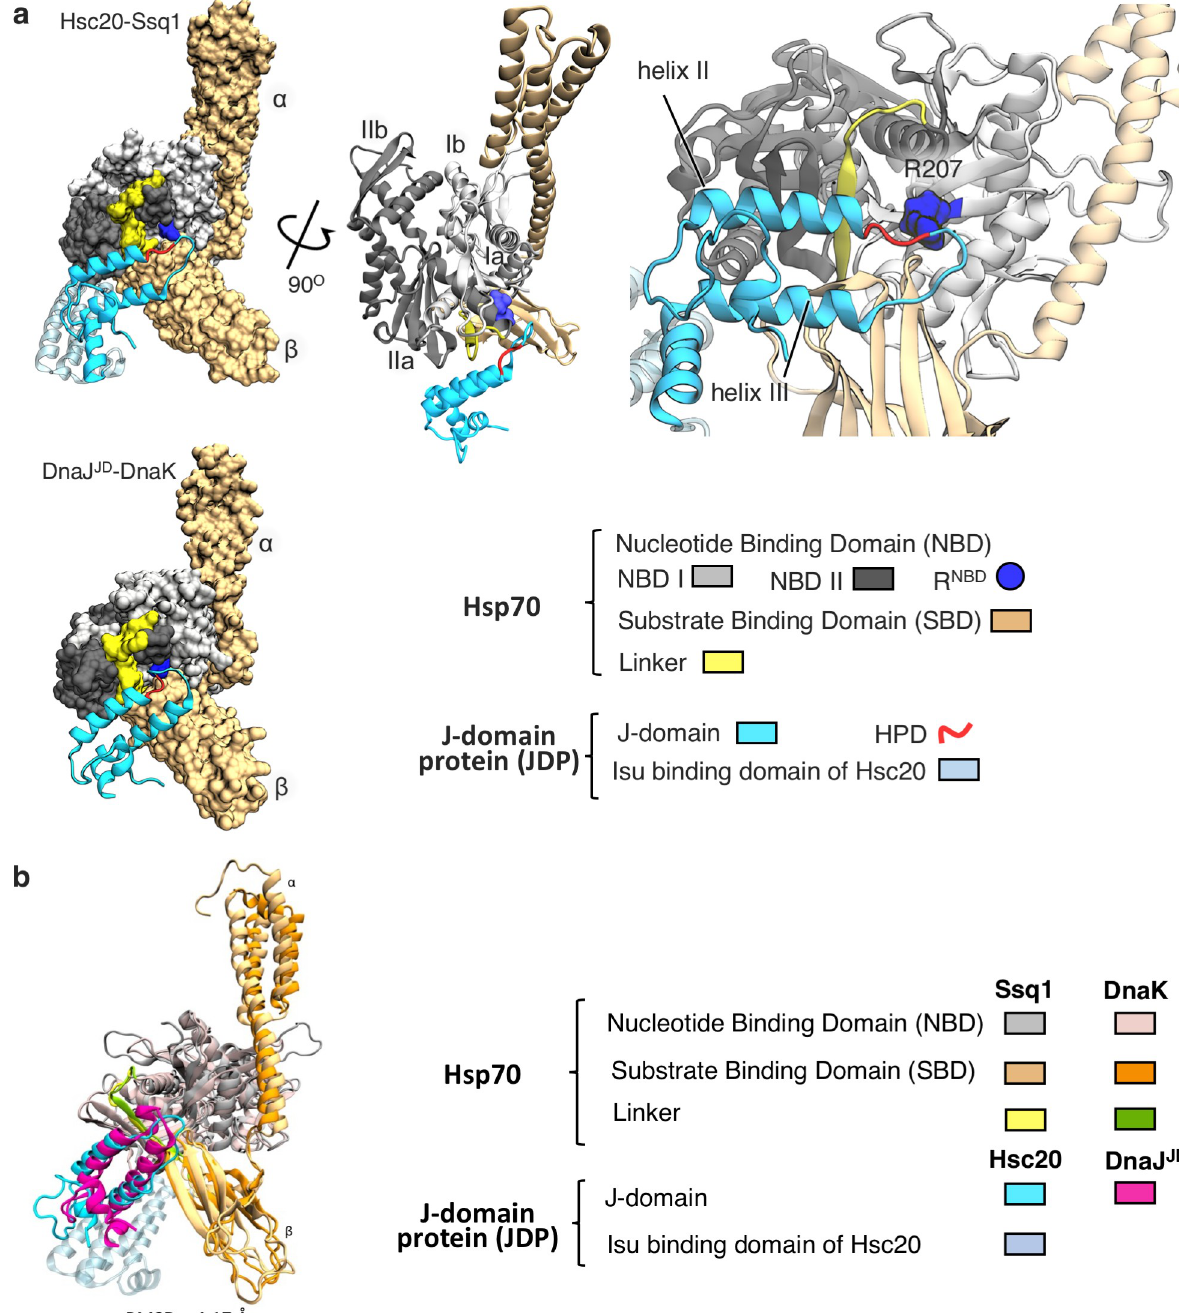
Fig 1. Binding mode of J-domain-Hsp70 complexes. (A) ( top left ) The dominant state of the Hsc20-Ssq1 complex obtained by protein-protein docking followed by MD refinement. Structure of S . cerevisiae Hsc20 (PDB ID 3UO3) was used along with a homology model of ATP-bound Ssq1, based on the X-ray structure of ATP-bound DnaK (PDB ID 4B9Q). The Ssq1 model had the expected architecture of an ATP-bound Hsp70: Nucleotide binding domain (NBD, grey) interacting with α and β subdomains of the substrate binding domain (SBD, brown) and the linker (yellow), in a groove between NBD subdomains Ia (light grey) and IIa (dark grey). To model the Hsc20-Ssq1 complex, conformational fluctuations of Hsc20 and ATP-bound Ssq1 were first characterized using MD simulations and clustering (S1 Fig). The obtained distinct conformers were then combinatorially docked. Based on the energetic and geometric criteria described in Methods, a representative set of 33 of the resulting complexes was selected for further refinement with MD simulations, and then clustered according to the positioning of the J-domain with respect to Ssq1 (S2 Fig). The model shown represents the dominant state with a population of 56%: J-domain of Hsc20 (cyan) interacts with Ssq1 at the NBD/SBD β , linker interface. HPD sequence (red) of the J-domain is positioned near the conserved R207 (blue) of the NBD. ( top middle ) View of the Hsc20-Ssq1